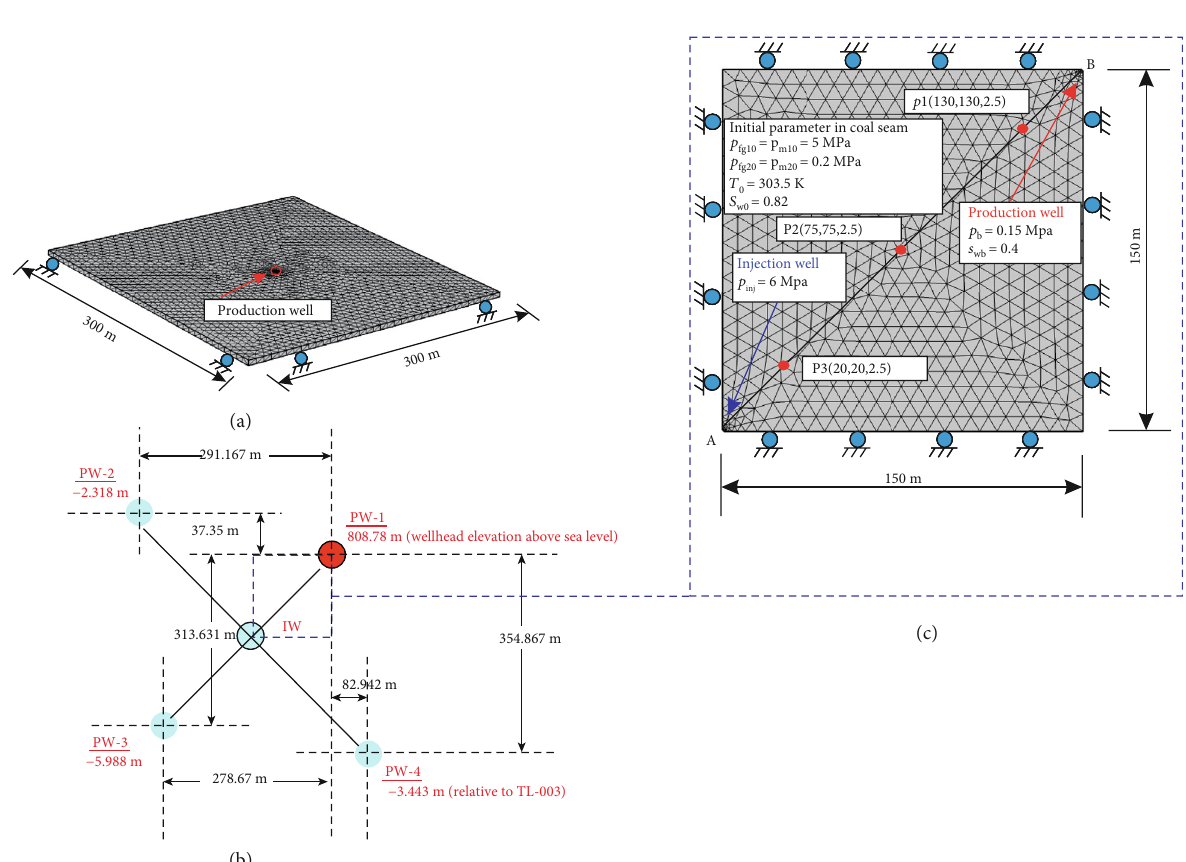
Figure 4: Geological model for numerical simulation. (a) Model validation. (b) Five-spot pattern [55]. (c) Model for ECBM